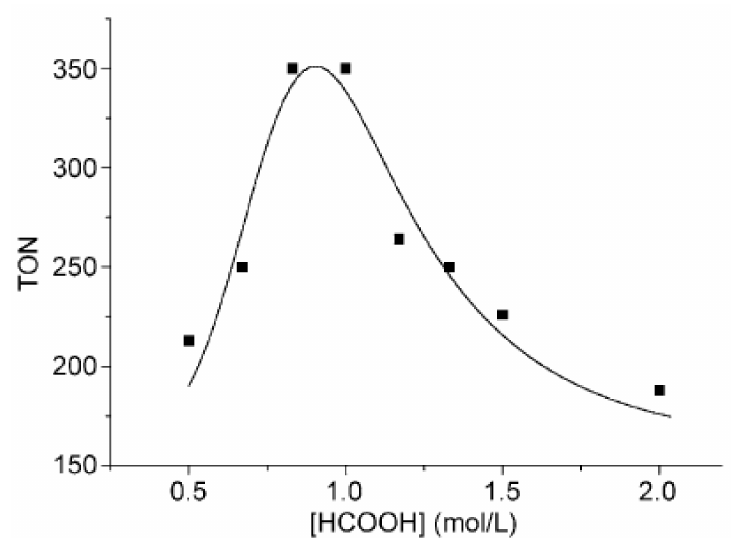
Figure 3. Effect of FA formic acid concentration on acetylene hydrocarboxylation. Reaction conditions: [Pd 2 (dba) 3 ] · CHCl 3 (2.5 mmol), Xantphos (50 mmol), benzoic anhydride (0.1 mmol), acetylene (initial pressure 15 atm, ca. 18 mmol), in THF (3 mL) at 100 ◦ C for 12 h (reproduced with permission from [28]. Copyright 2015 WILEY-VCH Verlag GmbH & Co.